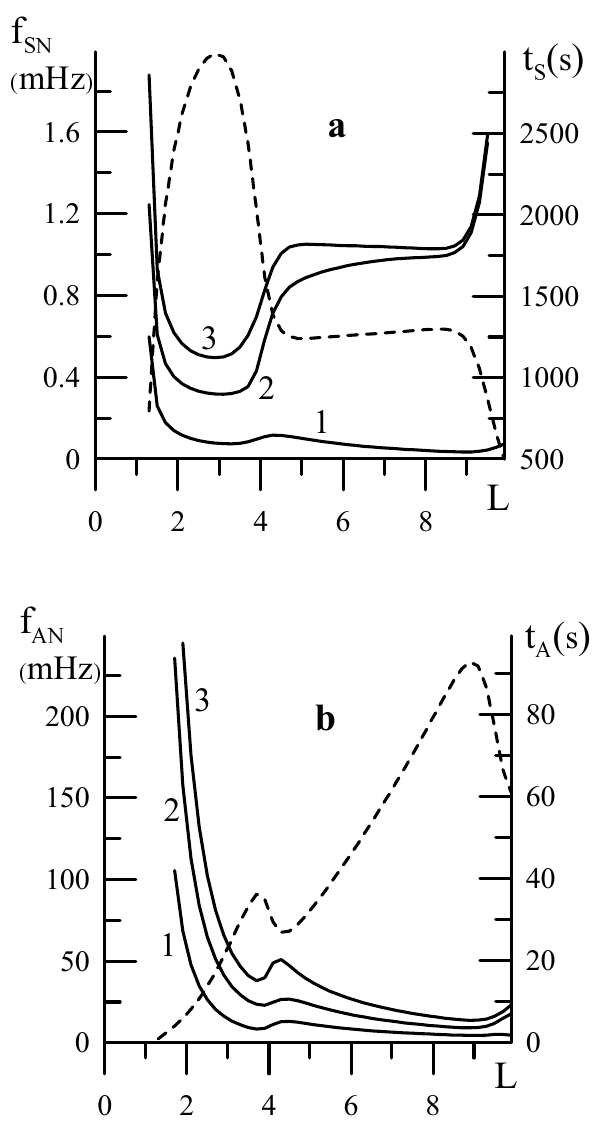
Fig. 3. (a) Distribution across the magnetic shells of eigenfrequen- cies f SN of the first three harmonics of standing SMS waves and the travel time along the field line between conjugate ionospheres t S with the SMS wave velocity C S . (b) Same, for a standing Alfv´en wave.